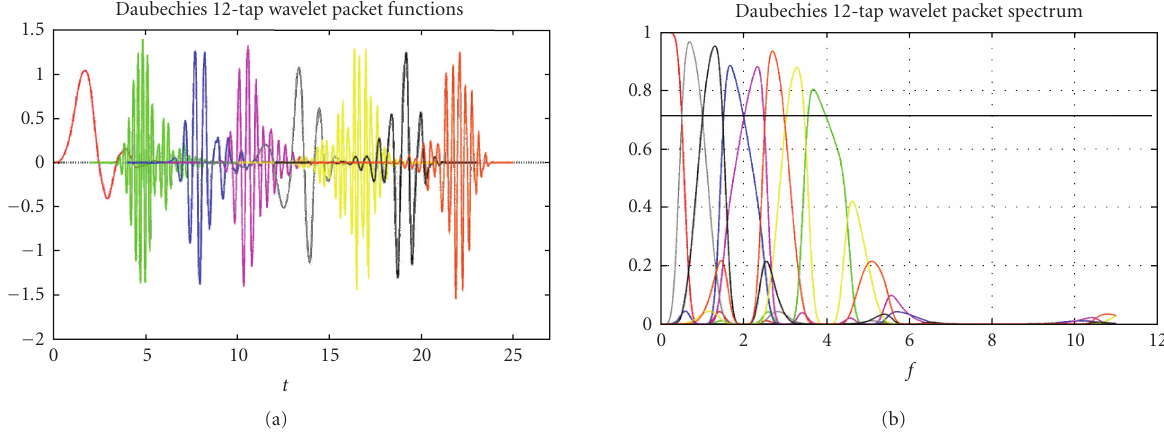
Figure 1: (a) Time and (b) frequency portrait for 12-tap Daubechies wavelet packets.